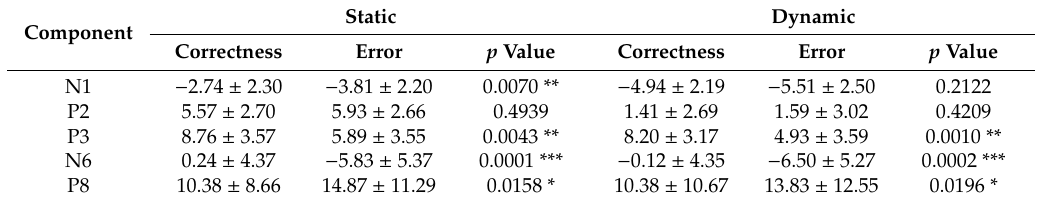
Table 2. Component values of correctness and error under static and dynamic stimulations.